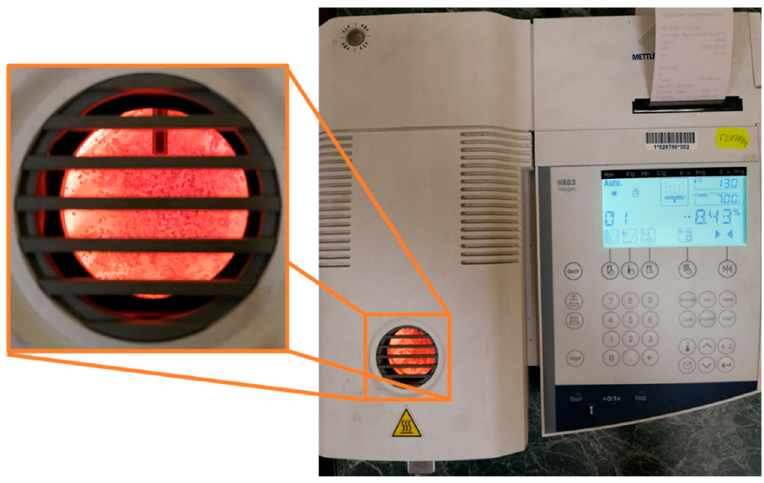
Figure 1. A study of the moisture content of oak sawdust using a scale dryer.